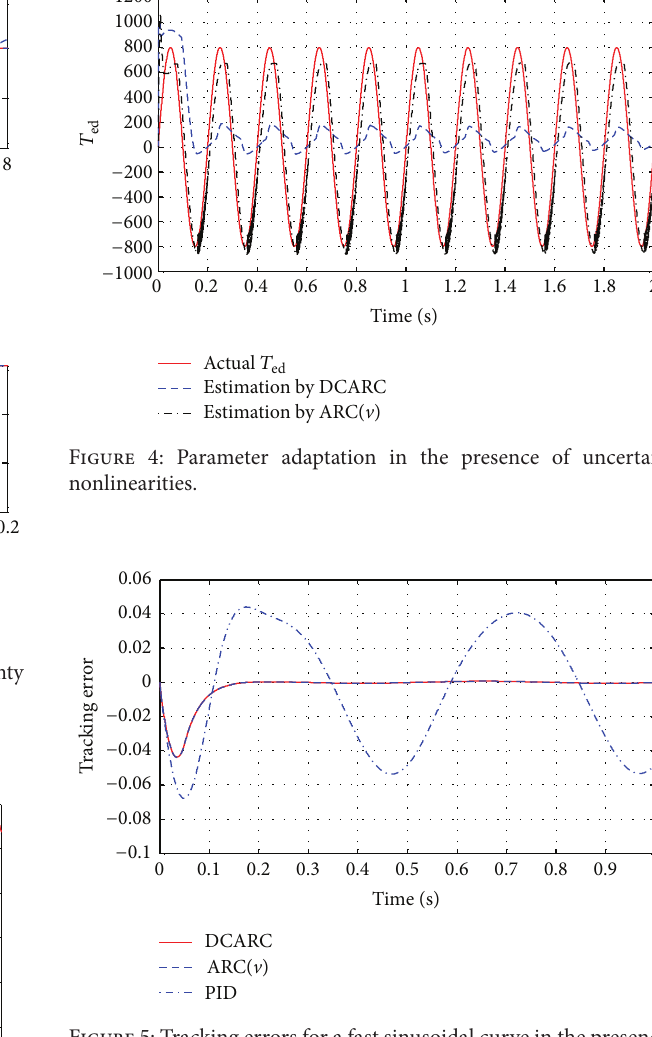
Figure 5: Tracking errors for a fast sinusoidal curve in the presence of parametric uncertainties only.